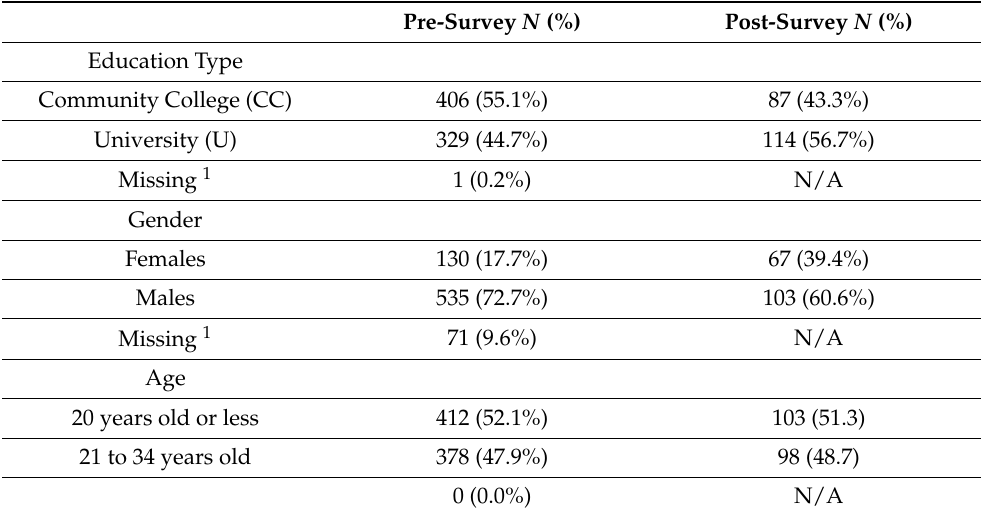
Table 1. Demographics of Pre- and Post-Survey Participants ( N = 790 pre-survey; N = 201 post sur-